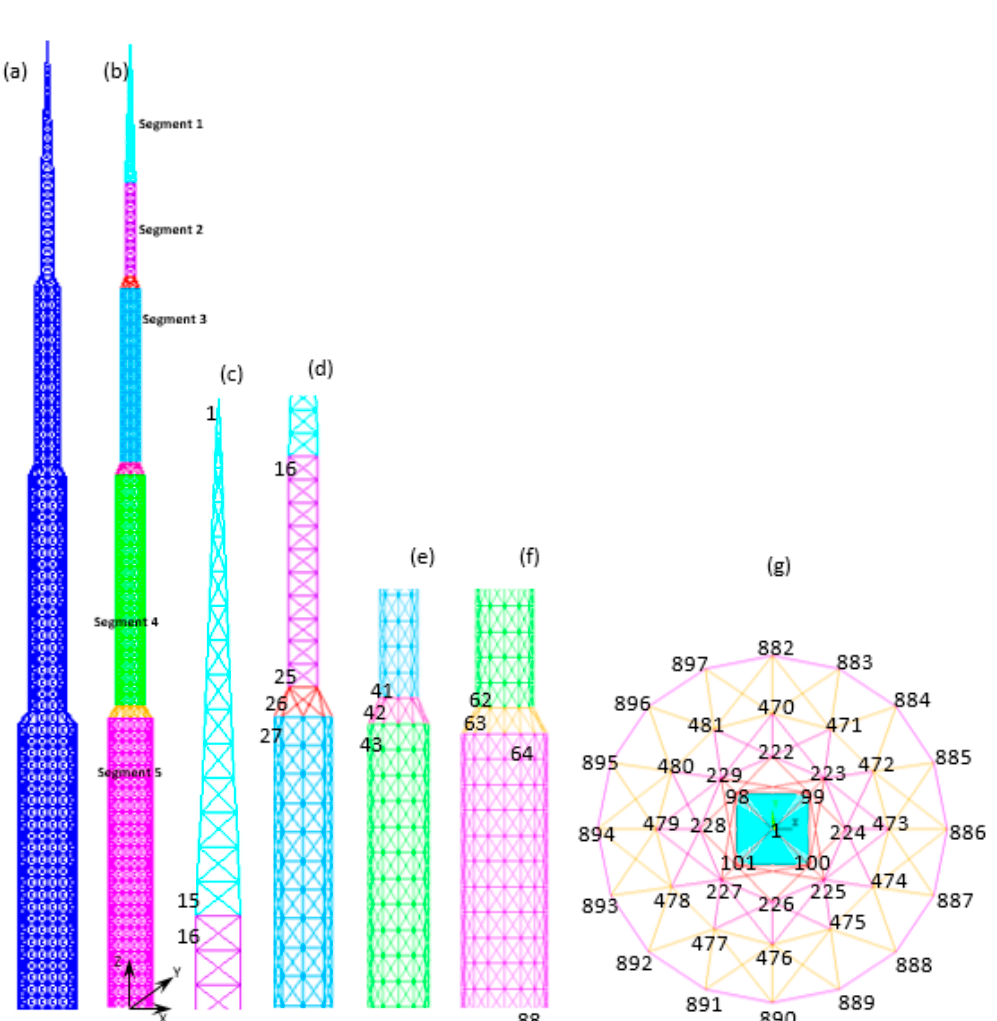
area taken as a sizing variable.